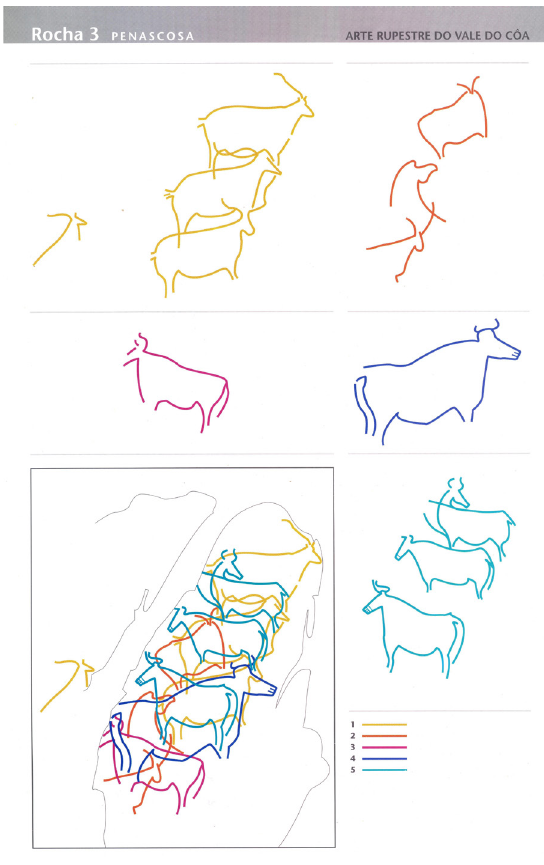
Figure 14. Relative chronology of superimposed motifs in Penascosa Rock 3, from 1 (oldest) to 5 (youngest). The two-headed aurochs motif depicting motion belongs to the panel’s last engraving phase. Drawing in Zilhão (1997, p. 381).